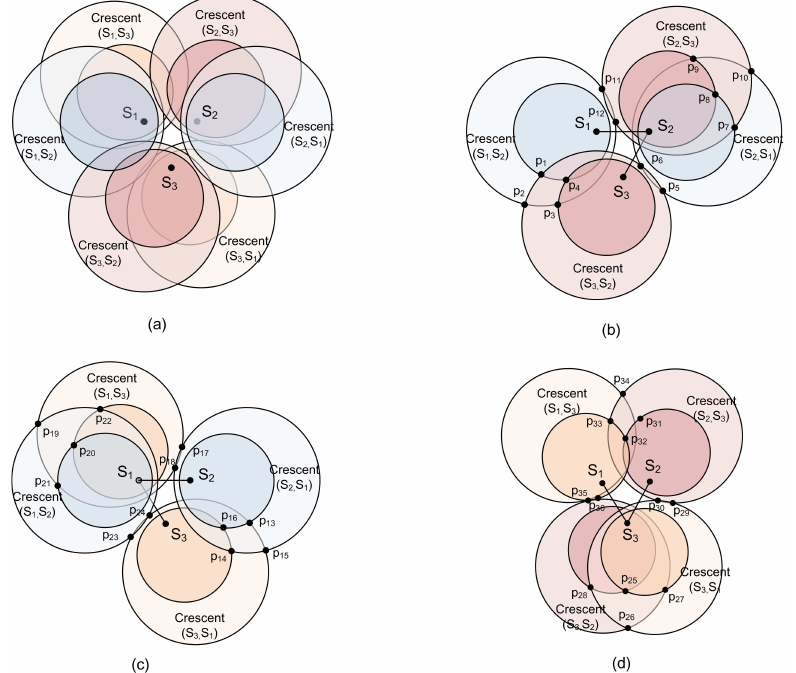
Figure 7. Crescent of each pair of SNs and location of 3 SNs and 2 GWs. The crescent region where the GW can decode both collided packets sent by the pair of SNs with capture effect and IC method, are shown in ( a ). In ( b – d ), the OPs are generated by the crescents corresponding to groups of sensor pairs { s 1 and s 2 , s 2 and s 3 } , { s 1 and s 2 , s 1 and s 3 } and { s 1 and s 3 , s 2 and s 3 } , respectively, such as { p · · · , p } in ( b 1 , p 2 , 12